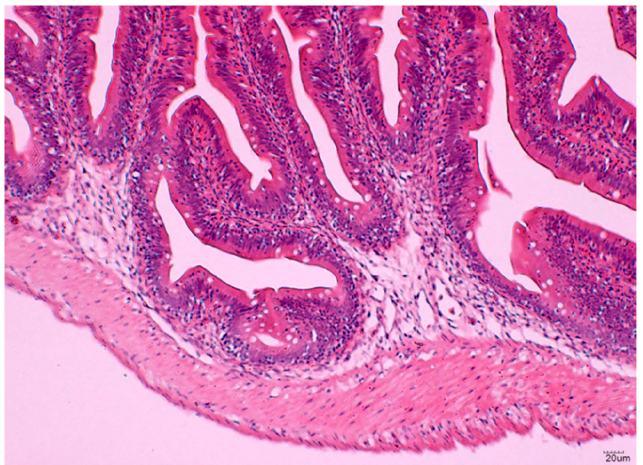
Figure 7. Group Cx, fed with normal feed Cargill, no structure of GALT developed in the lamina propria, H & E × 200. The diameter of the GALT and the number of lymphocyte cells within GALT were assessed in the vaccinated Red hybrid tilapia. The diameter of GALTs in Groups 1A and